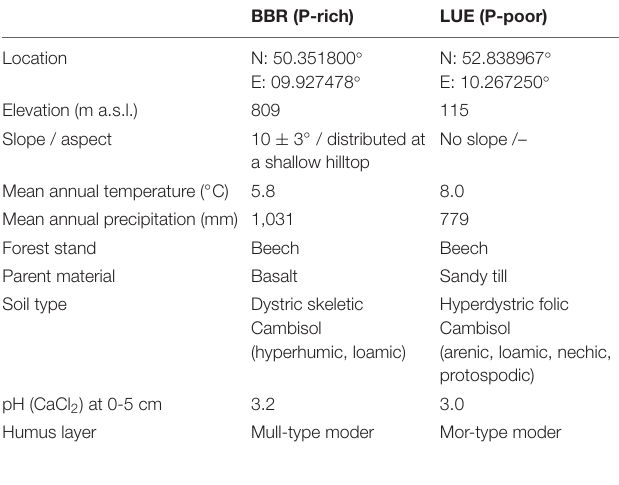
TABLE 1 | Characteristics of the two study sites, the P-rich site Bad Brückenau (BBR) and the P-poor site Lüss (LUE), for more detailed information please see Lang et al.